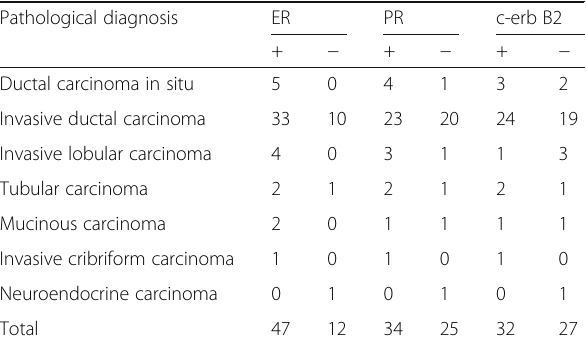
Table 4 Estrogen receptor (ER), progesterone receptor (PR), and c-erb B2 amplification characteristics of the lesions Pathological